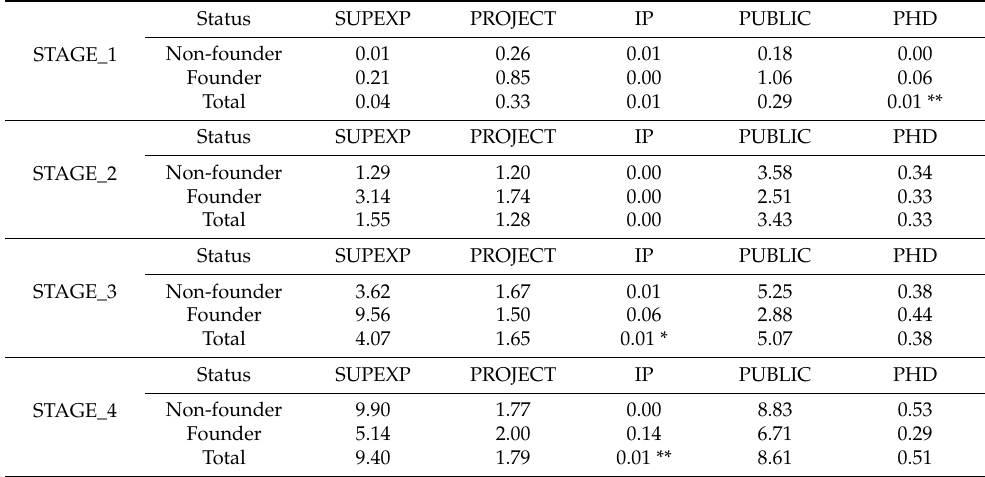
Table A2. Non-science workers’ means with statistical